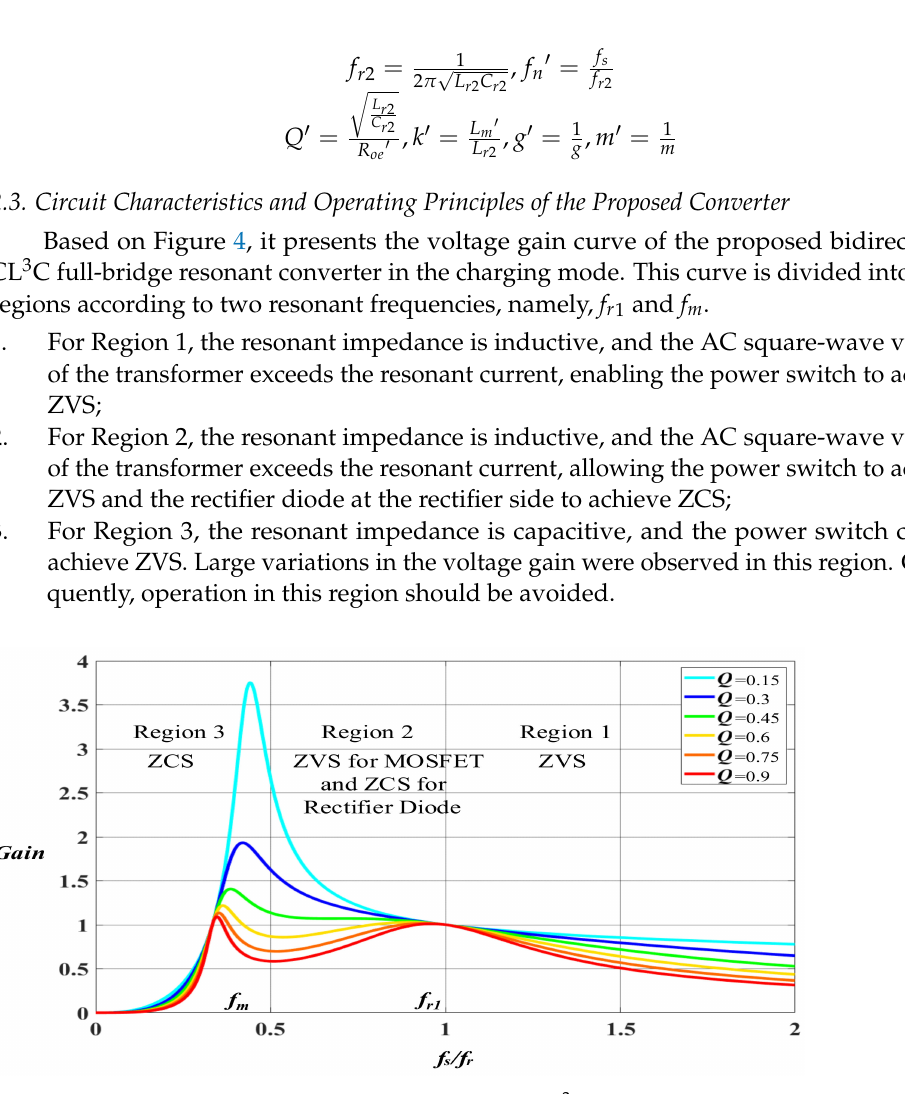
Figure 4. Voltage gain curve of the proposed bidirectional CL 3 C resonant converter in the charging mode. The operating circuit diagram of the proposed bidirectional CL 3 C full-bridge